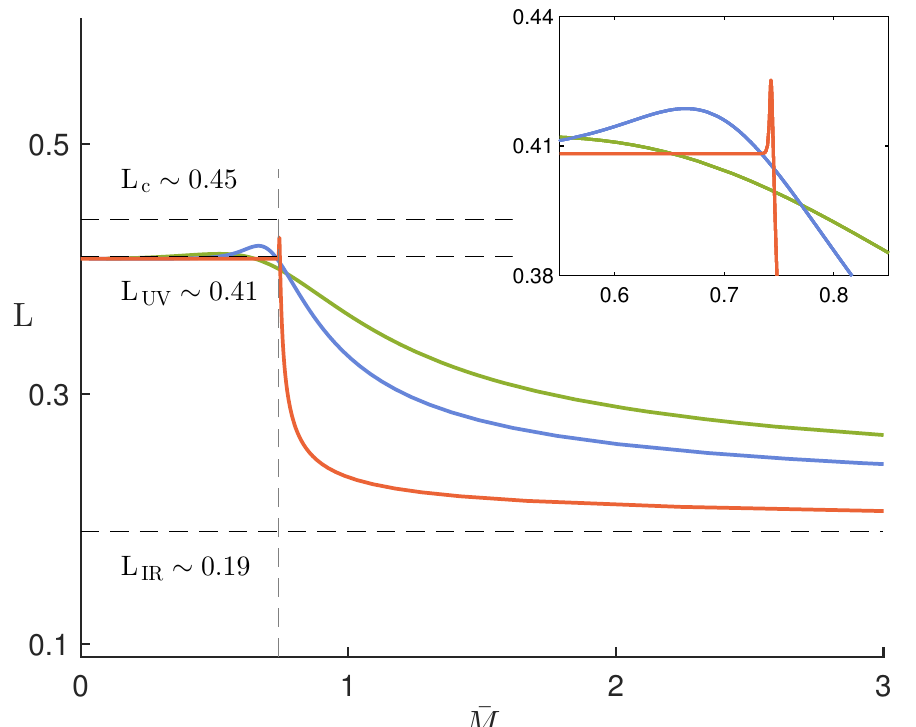
Figure 7. Dimensionless scale L across the quantum phase transition for various temperatures (cid:22) T = 0 : 1 ; 0 : 05 ; 0 : 005 (from green to orange). In the IR limit it asymptotes to L this is L UV . The inset zooms into the behavior around the critical point. For low temperature L maximizes around the critical temperature and reaches the maximum, L c = (4 + 2 (cid:12) 0 ) (cid:0) 1 = 2 . Since NEC ensures (cid:12) 0 < 1, thus L c is always larger than L IR . In the text we argue for this maximum to be a universal